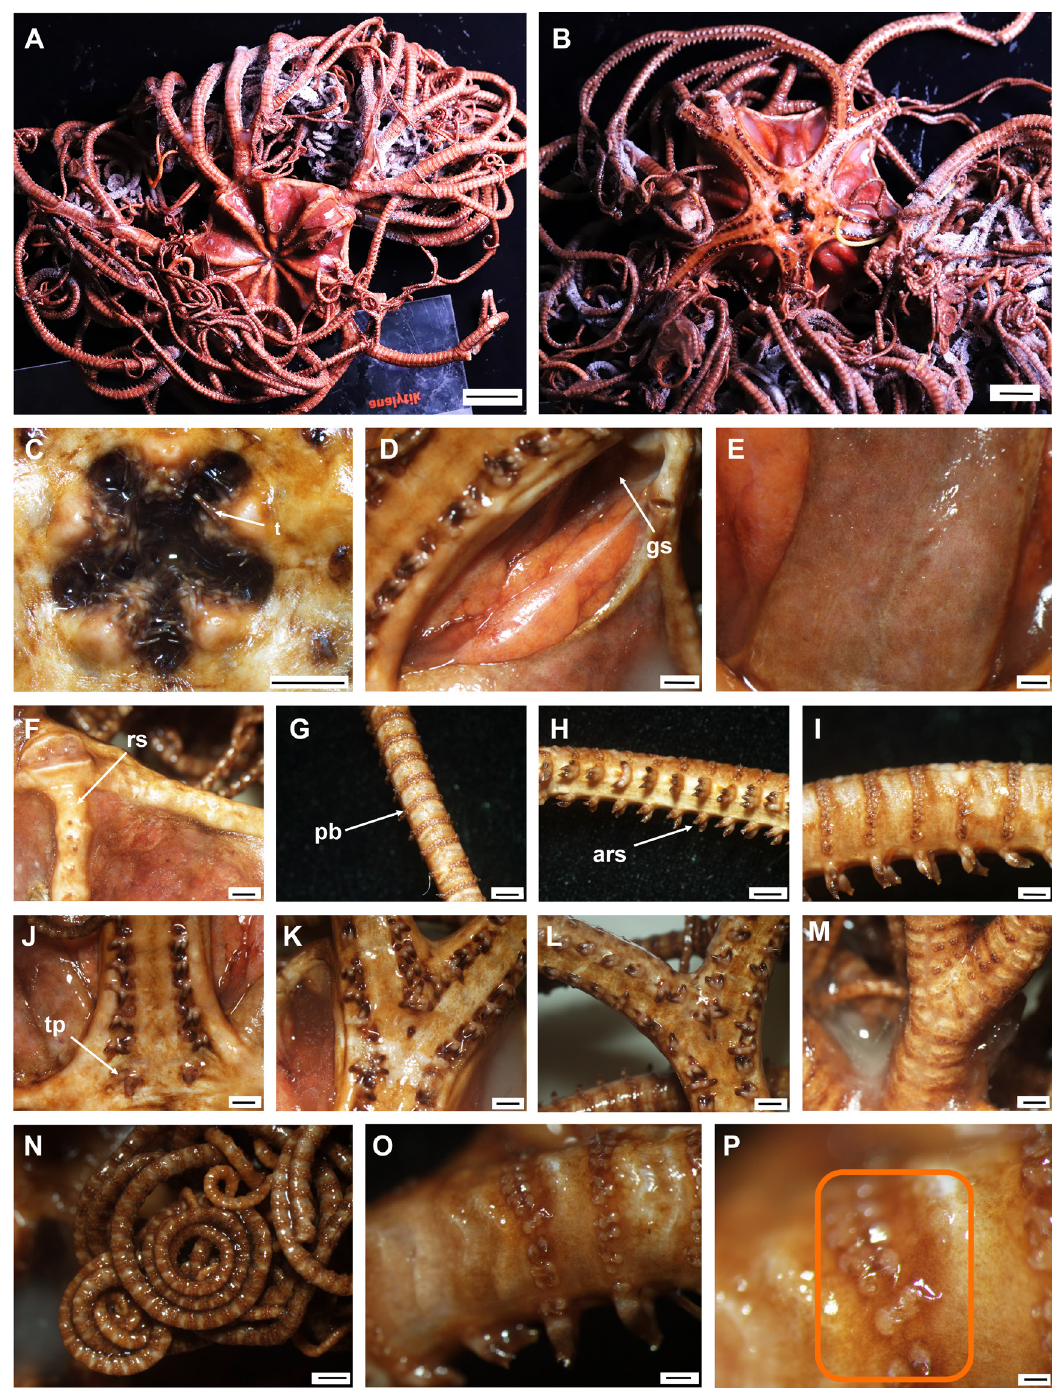
Fig. 11. Gorgonocephalus cf. dolichodactylus Döderlein, 1911 (IDSSE EEB-SW0006). A . Dorsal aspect. B . Ventral aspect. C . Oral frame. D . Genital slit. E . Ventral disc. F . Radial shield with peripheral plate. G . Dorsal arm. H . Ventral arm. I . Lateral arm. J . Ventral view of arm base. K . Ventral view of first arm branch. L . Ventral view of second arm branch. M . Dorsal view of second arm branch. N . Coiled distal arm branches. O . Pedicellarial band. P . Pedicellariae on pedicellarial band. Abbreviations: ars = arm spine; gs = genital slit; pb = pedicellarial band; rs = radial shield; t = teeth; tp = tentacle pore. Scale bars: A = 22 mm; B = 14 mm; C = 5 mm; D, F–H, J–N = 2 mm; E, I = 1 mm; O = 500 µm; P = 200